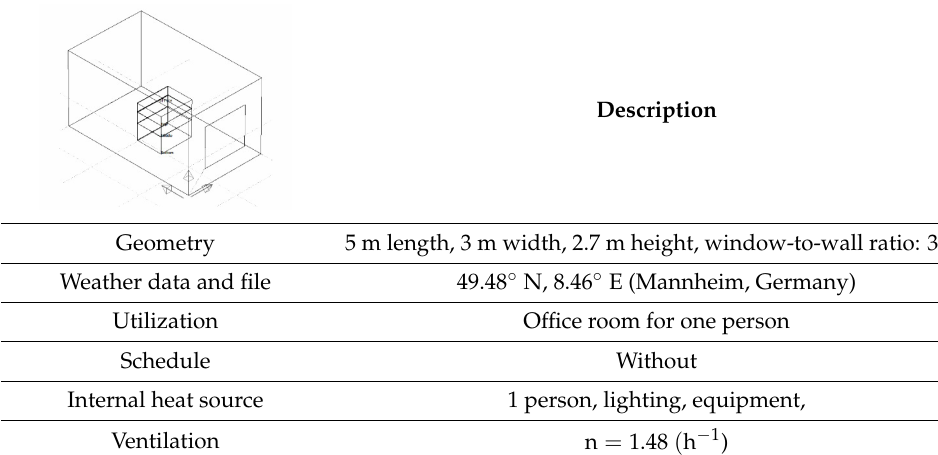
Table 3. Building model and simulation